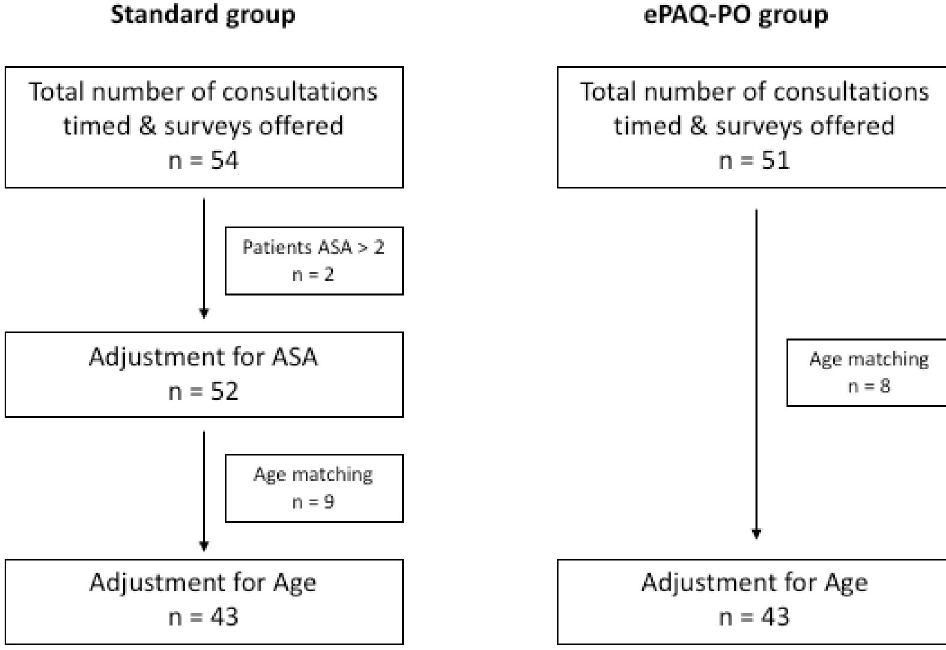
Fig 2. Recruitment flowchart and matching of